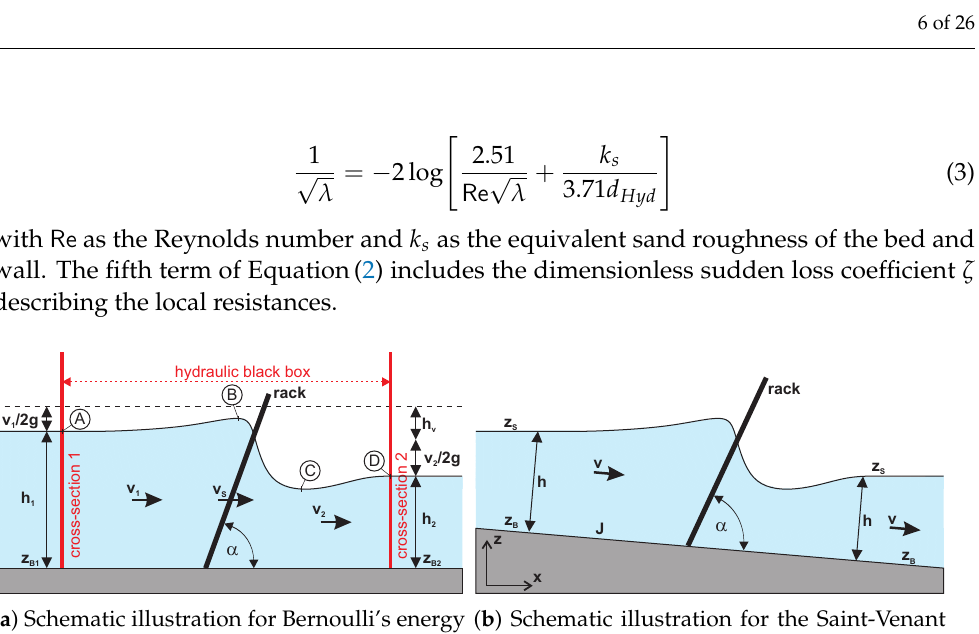
Figure 3. Schematic illustrations for the two theoretical approaches: ( a ) The Bernoulli equation compares the energy budgets between two cross-sections (Equation(2)). The area in-between contains the rack but remains as a hydraulic black box. ( b ) The Saint-Venant equations (Section4) do not require fixed cross-sections and cover the longitudinal profile entirely. Besides the bottom slope, they consider the bed, wall, and viscous